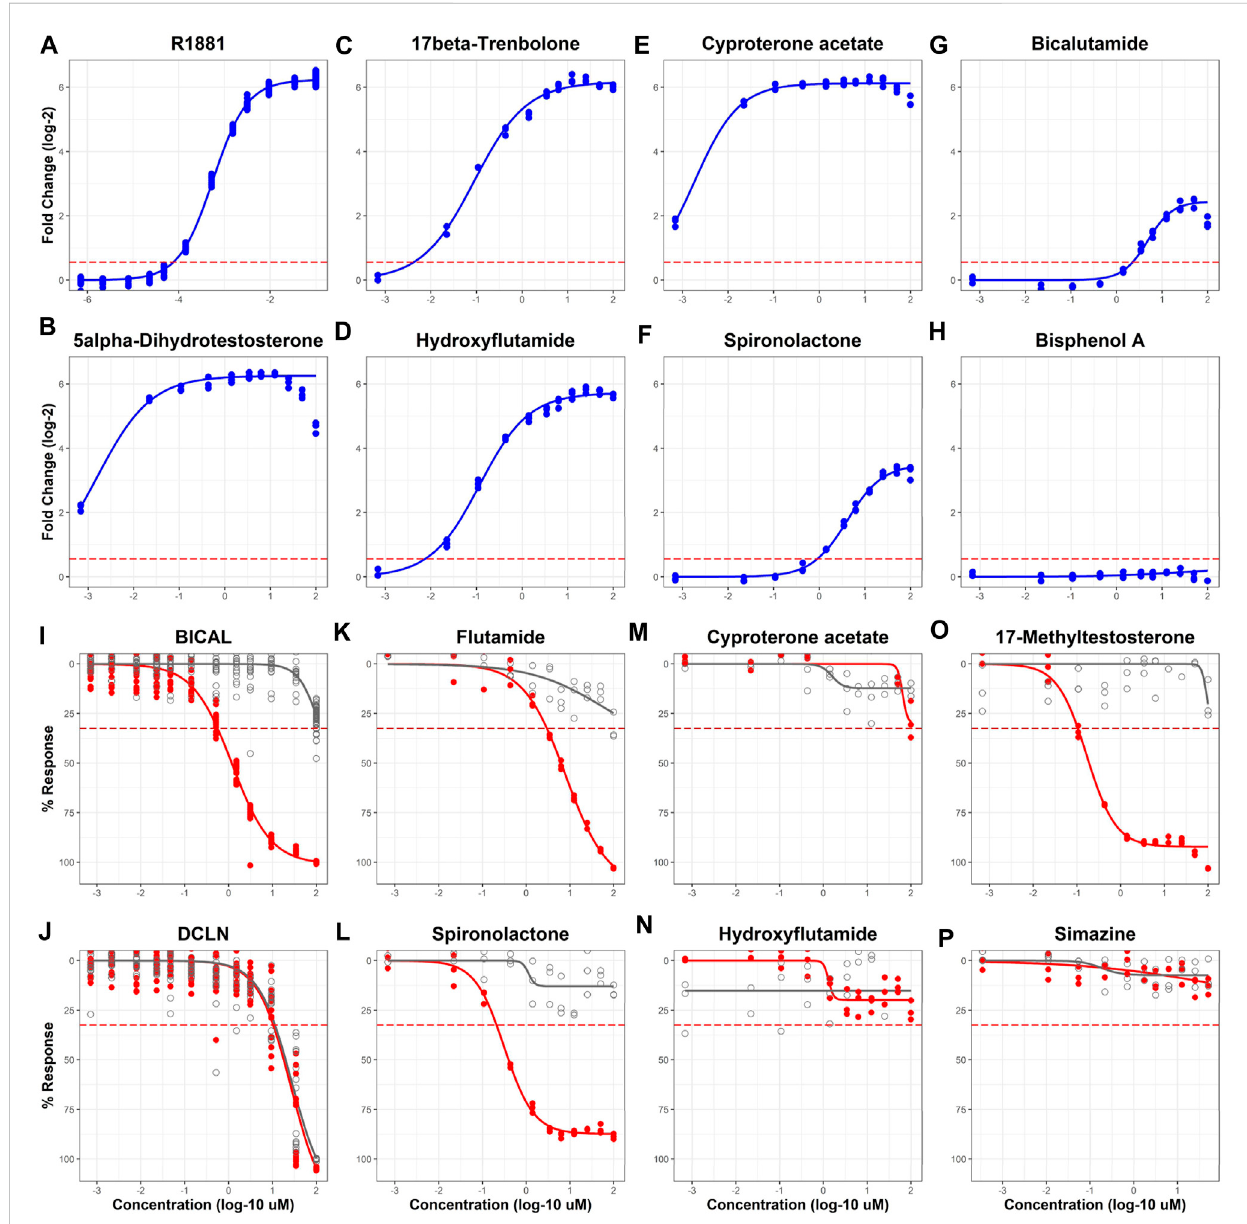
FIGURE 3 Sampleagonistandantagonistmodeconcentration-responsecurvesfor128evaluationchemicals.AR2cellswereexposedto128uniquechemicals at concentrations ranging from 691 pM to 99.9 µM for 18 h in both agonist [blue curves, (A – H) ] and antagonist modes [red curves, (I – P) ]. Micromolar concentrations are expressedas log 10 ( x -axis). Responses are expressedas fold change (log 2) over DMSO vehiclefor agonists (A – H) and %response (% maximal positive control) for antagonists (I – P) . Concentration-response curves were fi t using tcpl_Lite. The red dotted lines represent the activity thresholds de fi ned by the baseline median absolute deviation (bmad) for both agonists (5 x bmad) and antagonists (3 x bmad). Antagonist mode testing utilized a post hoc cell viability assay (I-P, grey) to identify responses confounded by cytotoxicity. Concentrations shown for cell viability re fl ect those for the 18-h exposure period and do not account for reagent addition during the 2-h reagent incubation. Data represent individual wells from three independent experiments.BICAL and DCLNare thedesignationsfor bicalutamideanddichlone controls. Theagonistandantagonistresponse curves for all 128 chemicals can be found in Supplementary Figures S1, S2,